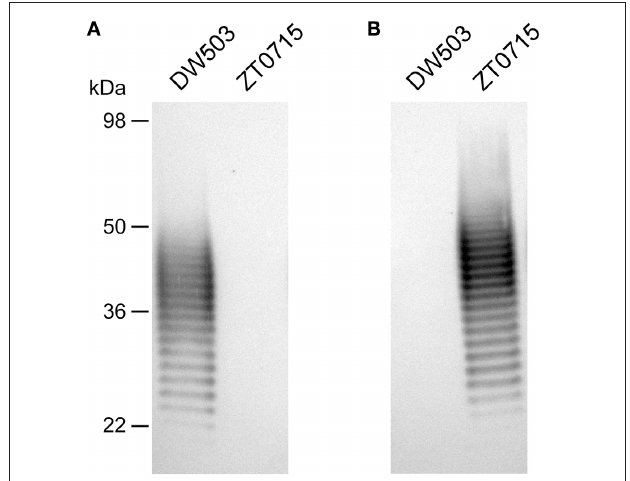
FIGURE 1 | Western immunoblot analysis of B. thailandensis LPS antigens. Purified B. thailandensis DW503 (WT) and ZT0715 ( oacA mutant) LPS antigens were probed with (A) the B. thailandensis OPS-specific mAb, Pp-PS-W or (B) the B. mallei OPS-specific mAb, 3D11. The positions of protein molecular size standards are indicated on the left.